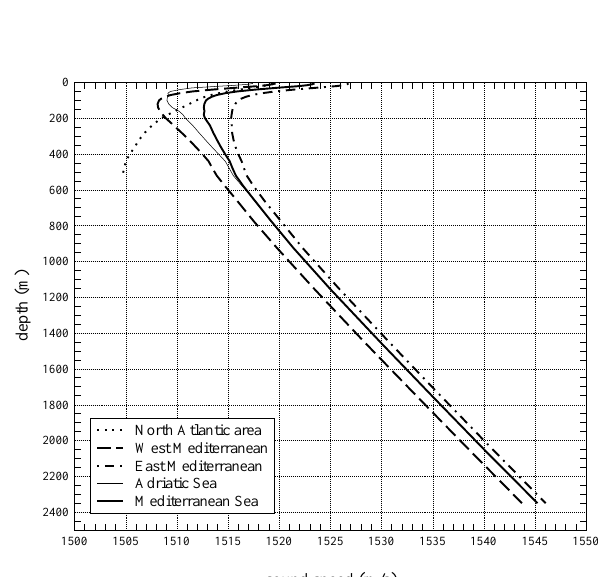
Fig. 2. Sound speed annual mean at 50m.